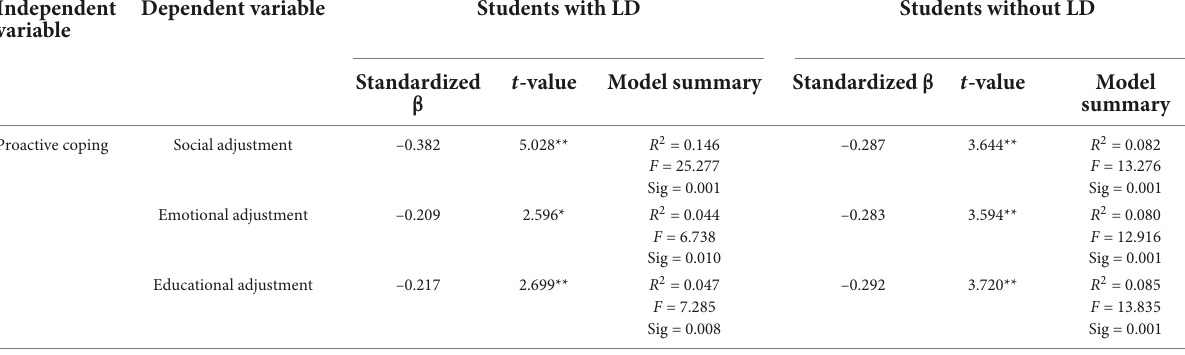
TABLE 2 Linear regression analysis of proactive coping and adjustment among students with and without learning disabilities.